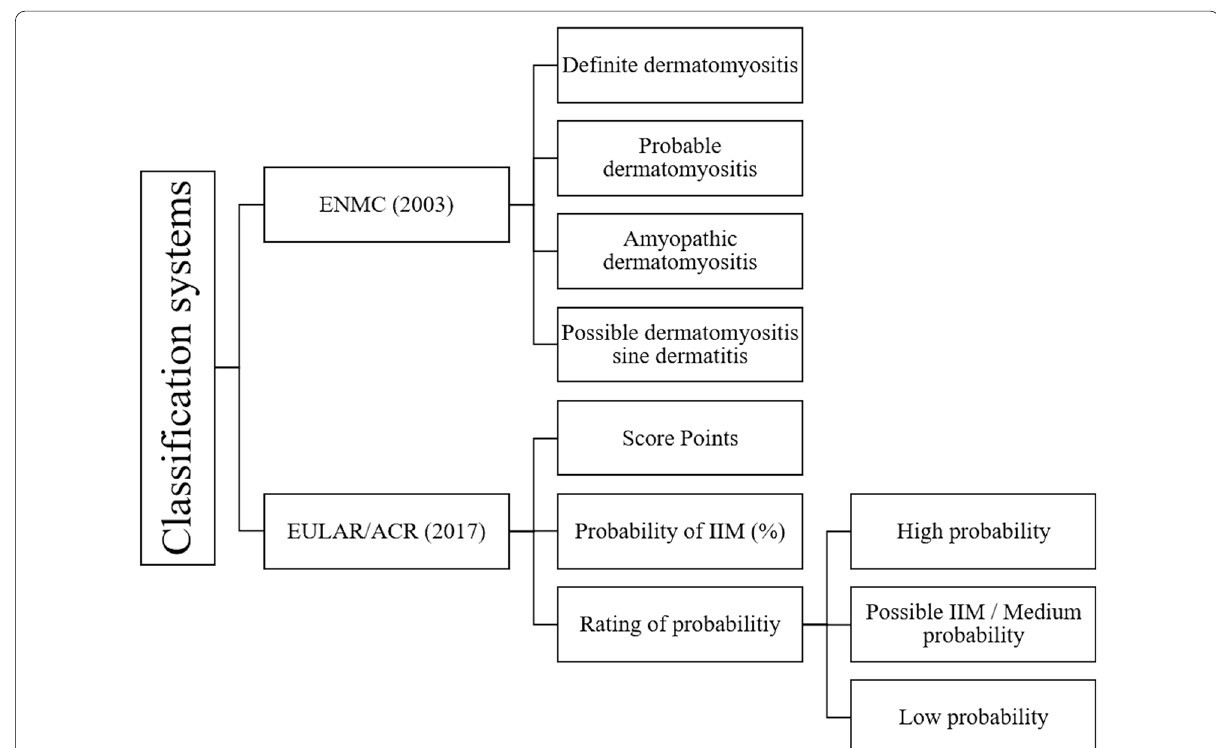
Fig. 2 Overview chart to show the classification possibilities according to the ENMC (2003) and EULAR/ACR (2017) approaches and thus the classification clusters used in this